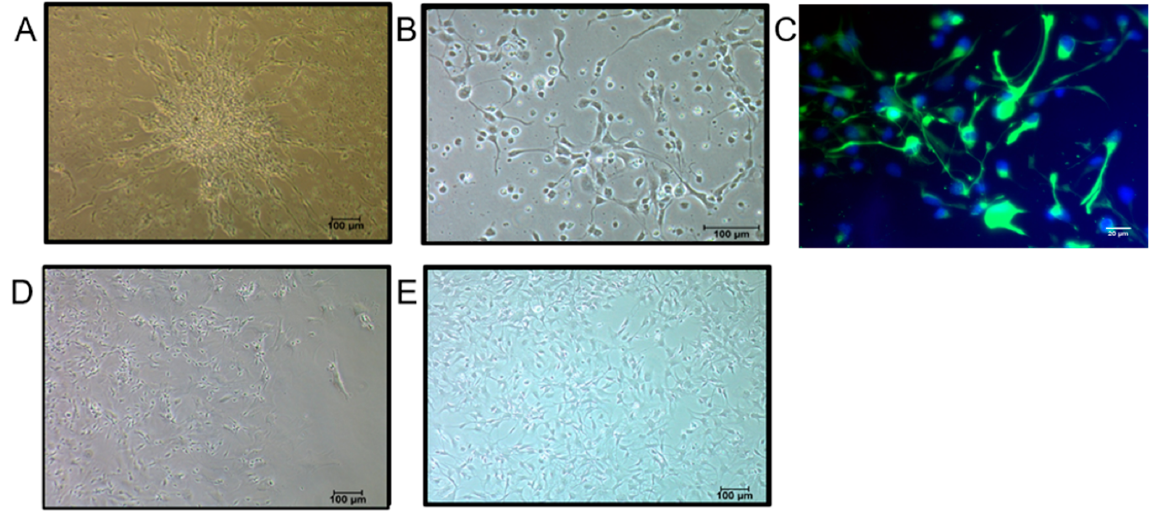
Figure 1. Morphological features of human fetal neural stem cells and differentiating astrocytes. ( A ) Neurosphere formation seen after 24–48 h of fetal neural stem cell (FNSC) isolation. ( B ) FNSCs in monolayer culture display unipolar morphology. ( C ) Immunofluorescence image of FNSCs stained for neural stem cell marker Nestin (green). Nuclei are stained with DAPI (blue). Morphological changes seen at ( D ) day 7, ( E ) day 14 of astrocytic differentiation. Differentiated cells are larger and show flattened morphology.